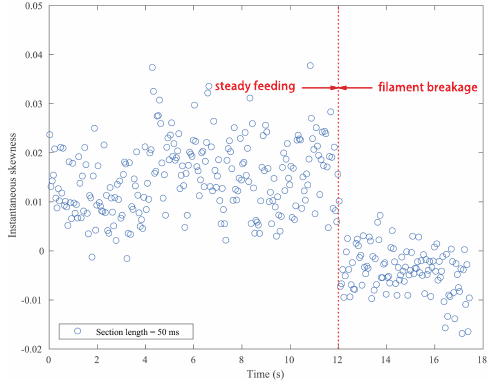
Figure 9. Instantaneous skewness of AE signal for Test #2 (section length = 50